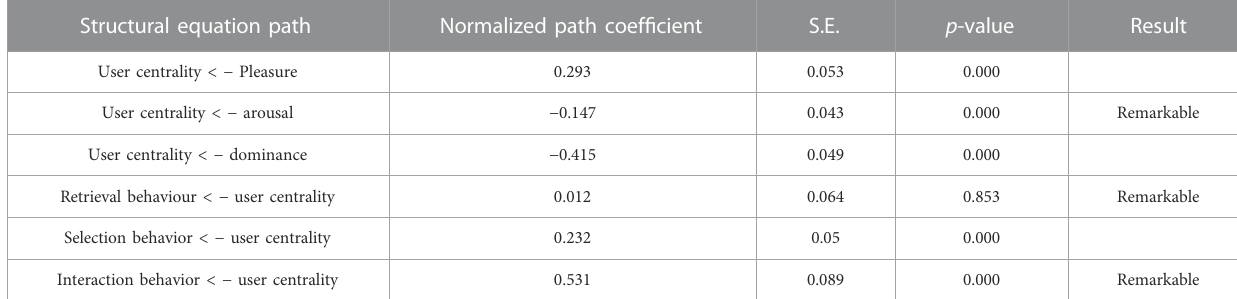
TABLE 10 Model path inspection